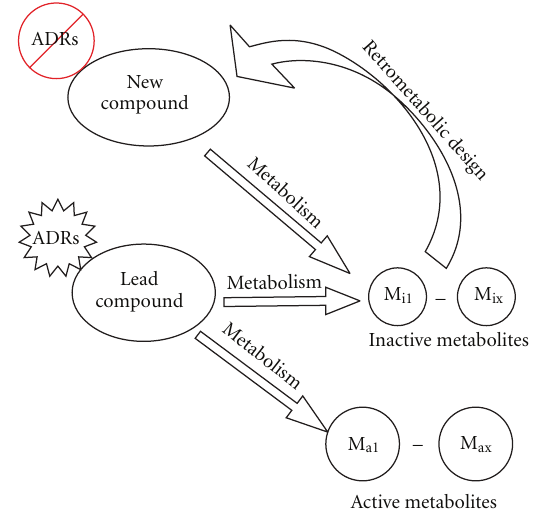
Figure 2: Concept of retrometabolic drug design in which a new lead compound is created based on an inactive metabolite of a pre- vious lead compound.